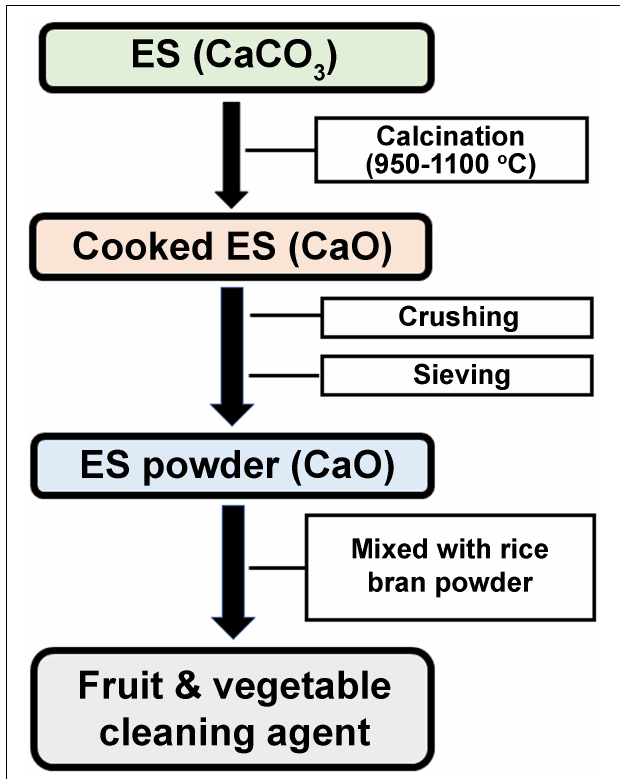
FIGURE 5 | Schematic presentation of patent CN107057890A describing a method to prepare a cleaning agent for fruits and vegetables based on calcinated ES